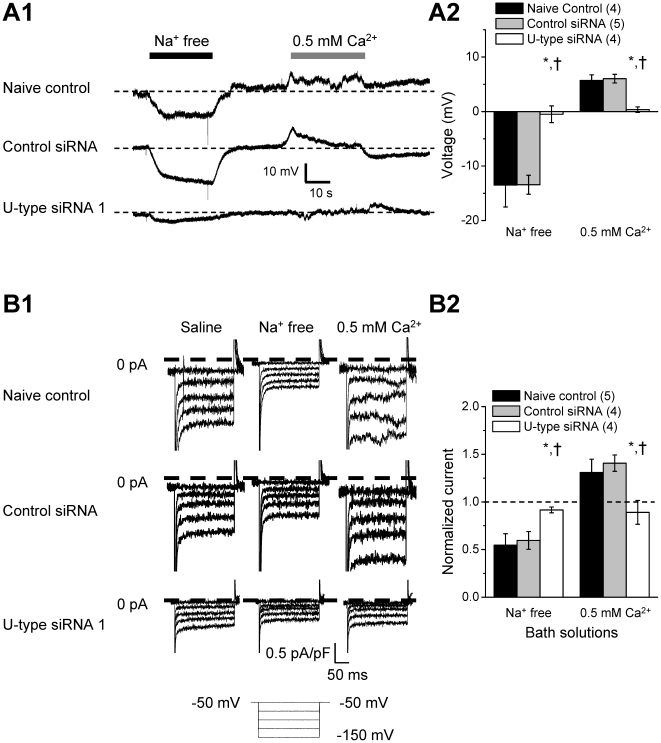
Low extracellular Ca2+ depolarizes the membrane
potential by enhancing U-type channel activity in RPeD1 neurons.(A) U-type channel knockdown prevents low extracellular
Ca2+-induced membrane depolarization. (A1)
Representative voltage traces of naive control, control siRNA, and
U-type siRNA treated RPeD1 neurons perfused with saline,
Na+ free or low Ca2+ saline. Partial
U-type knockdown reduces membrane hyperpolarization by
Na+ free solution or depolarization by 0.5 mM
Ca2+. (A2) Average voltage differences of naive
control (n = 4), control siRNA
(n = 5), and U-type siRNA
(n = 4) treated RPeD1 under Na+
free or 0.5 mM Ca2+ perfusion. (B) Low extracellular
Ca2+ increased Ileak is reduced in U-type
knockdown. (B1) Representative Ileak traces of naive control,
control siRNA, and U-type siRNA treated RPeD1 in saline,
Na+ free, and 0.5 mM Ca2+ solution.
(B2) Average ILeak normalized to saline of naive control
(n = 5), control siRNA
(n = 4), and U-type siRNA
(n = 4) treated RPeD1 in Na+ free,
and 0.5 mM Ca2+ at −100 mV. The dashed line
represents the current activity in saline. Data are presented as mean
± SEM. * and † indicate significant difference
(P<0.05) between naïve control and U-type RNAi treatment and
control RNAi and U-type RNAi treatment, respectively.